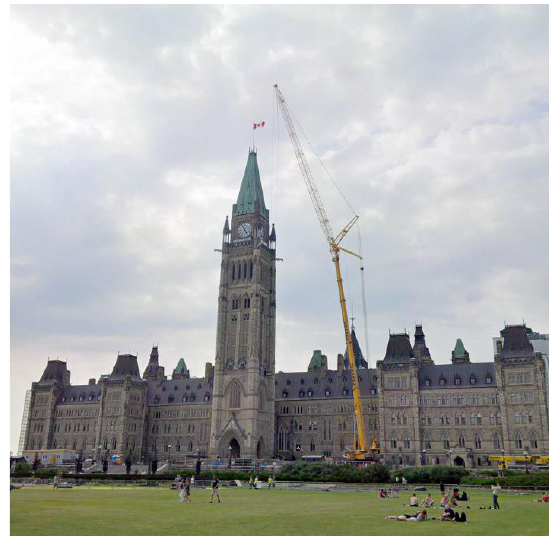
Figure 1: Photography of Peace Tower for SFM photogrammetry using a crane (HCS,